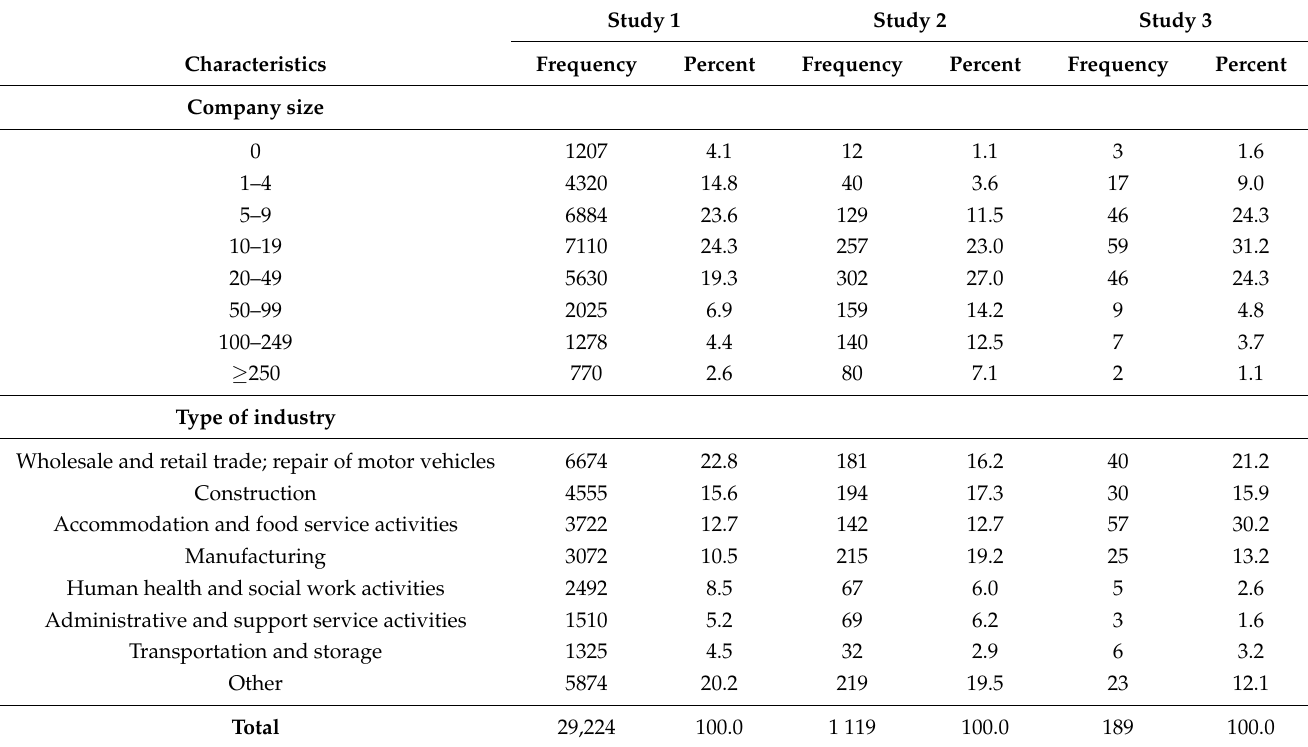
Table 1. Descriptive statistics for